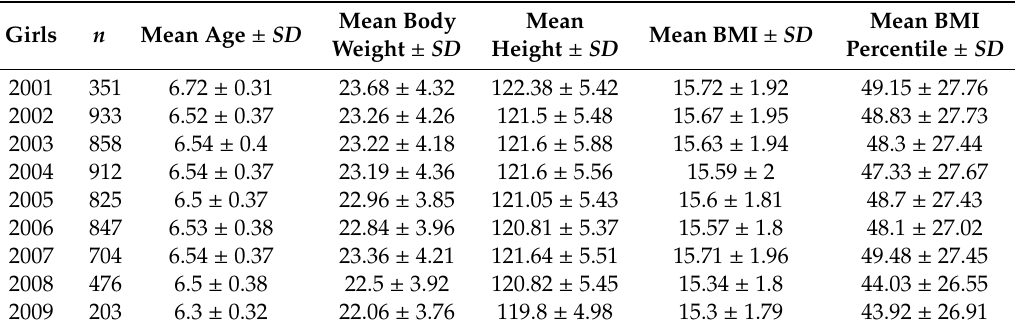
Table 3. Mean age, body weight, height, BMI and percentile BMI in boys by birth year. Mean Body Boys n Mean Age ± SD